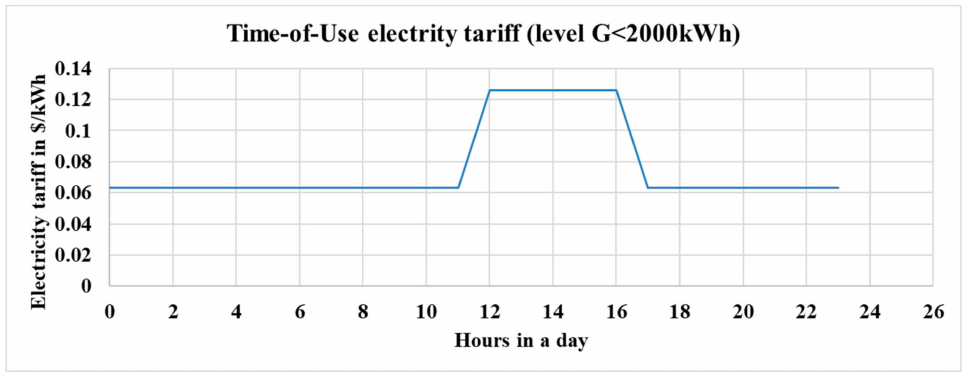
Figure 14. Updated electricity tari ff for a feed-in tari ff (FIT) scenario.